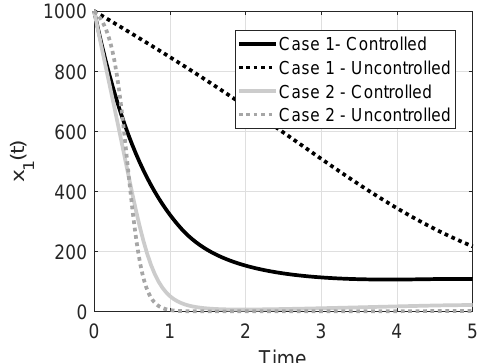
Figure 5. Evolution of the number of x 1 ( t ) subjects in Case 1 (black line) and Case 2 (grey line) with (continuous line) and without control (dotted line).